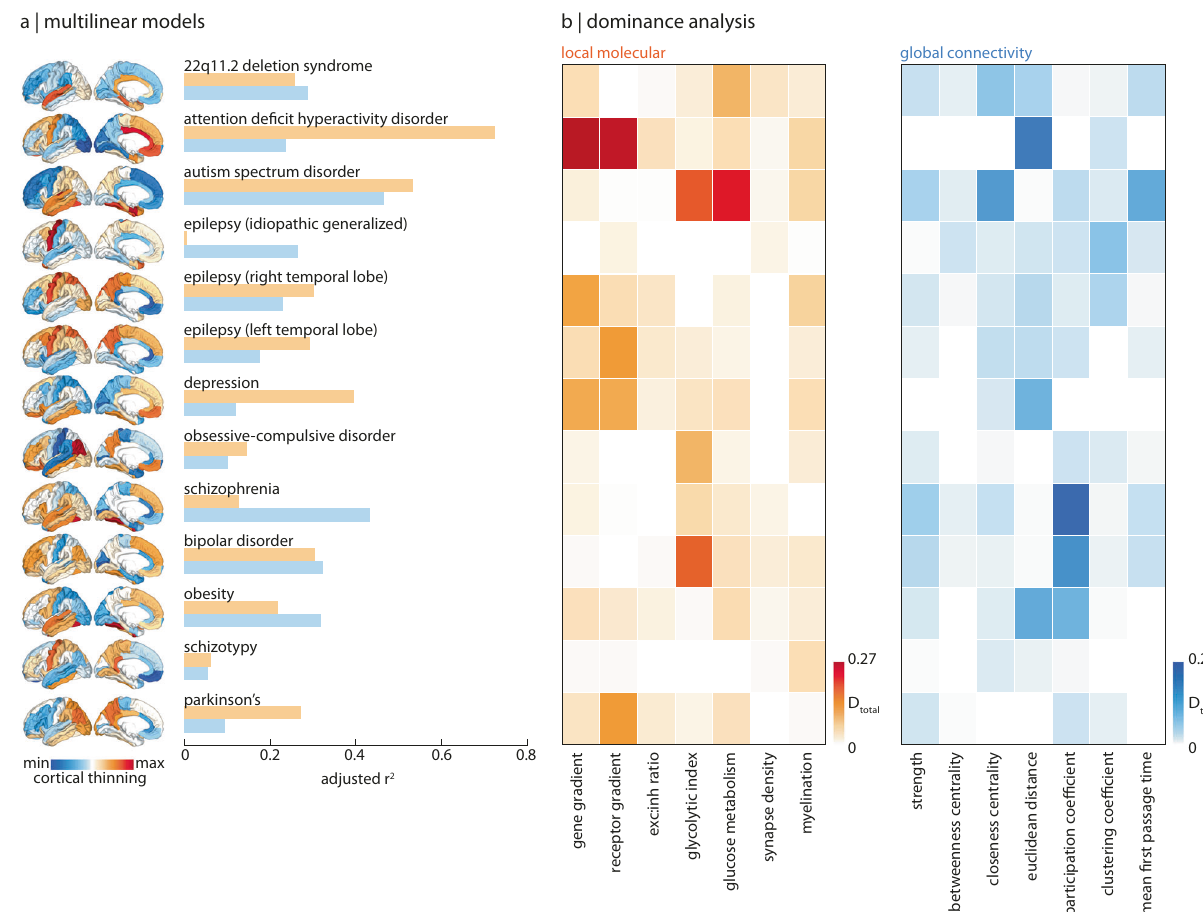
Fig. 2 | Local and global contributions to disorder-speci fi c cortical morphol- ogy.a Atotaloftwenty-sixmultilinearmodelswere fi tbetweenlocalmolecularand global connectome predictors to cortical abnormality maps of thirteen different disorders (surface plots, left). Adjusted R 2 is shown in the bar plot (orange: